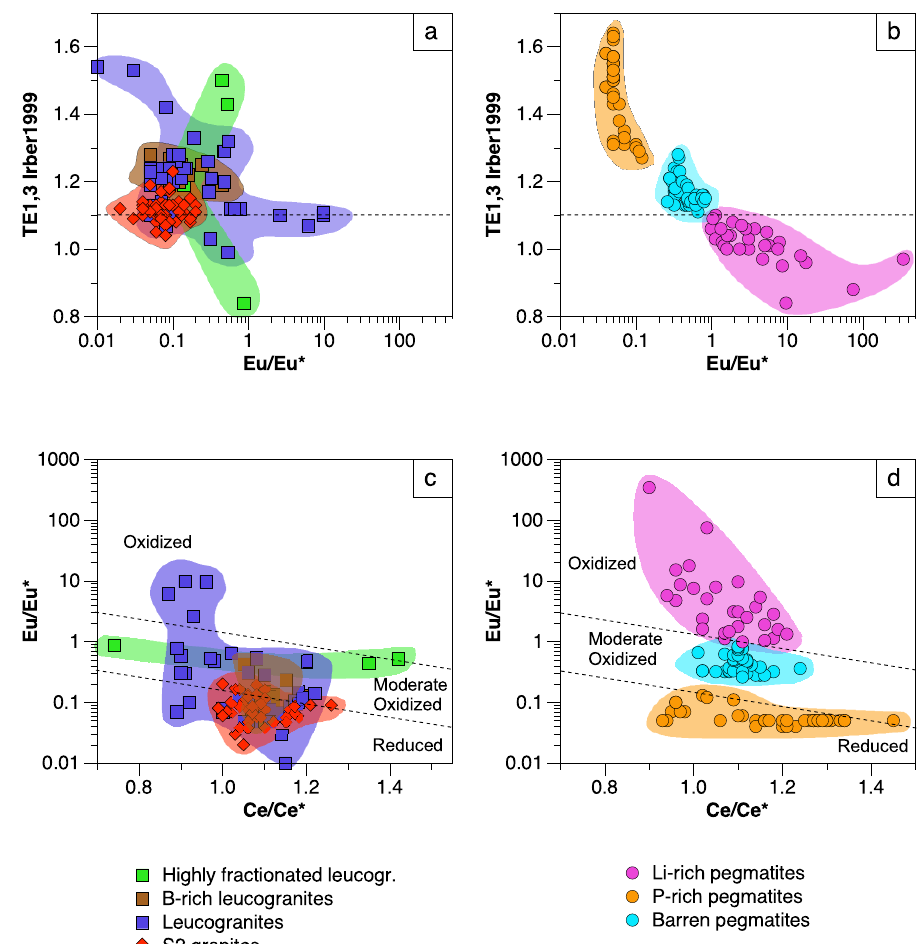
Figure 10. Binary plots of ( a , b ) the Eu anomaly (defined as Eu/Eu* = Eun/(Smn × Gdn)0.5) and the Te1,3 value for the tetrad effects calculated according to the procedure of Irber [107]; and ( c , d ) the Ce anomaly (defined as Ce/Ce* = Eun/(Lan × Prn)0.5) versus the Eu anomaly; for the apatite from granitic and pegmatitic lithologies, respectively.